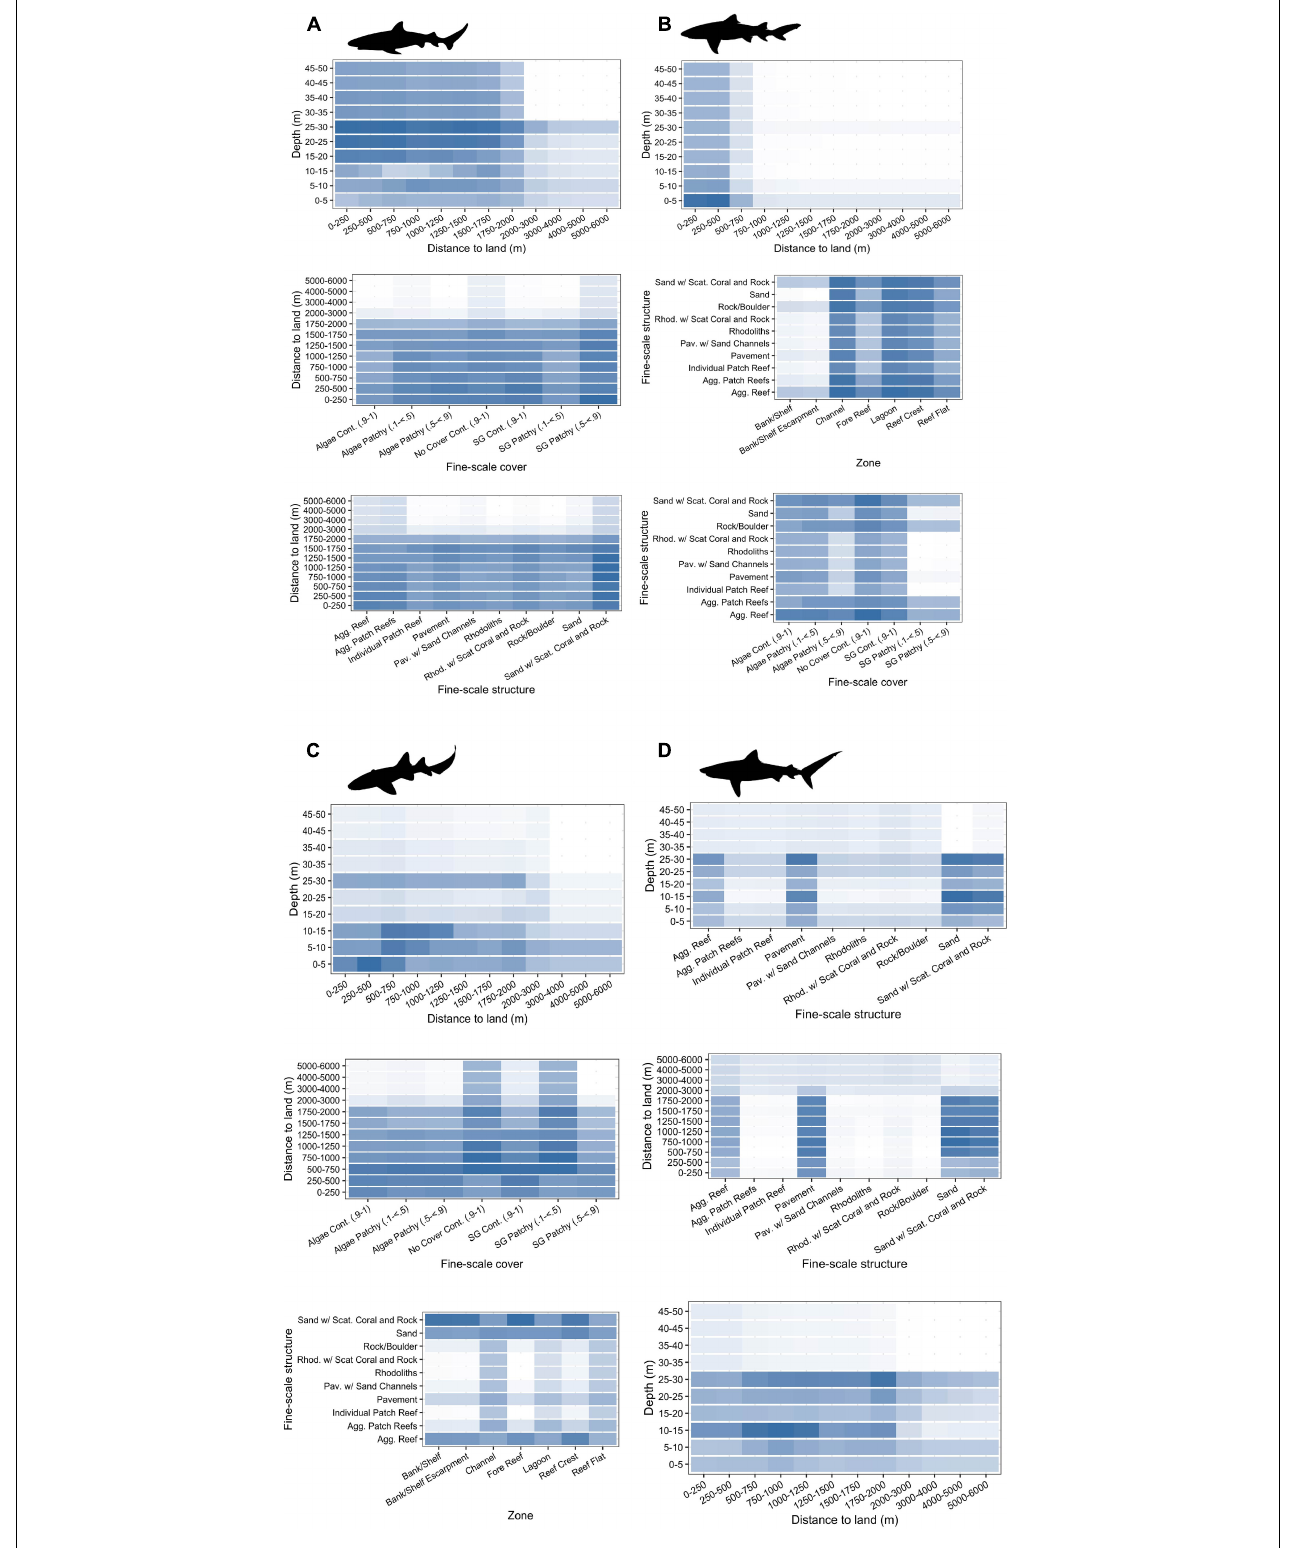
FIGURE 4 | Top three two-way interactions (ordered from top to bottom) displayed and extracted from random forest models for (A) Caribbean reef sharks, (B) lemon sharks, (C) nurse sharks, and (D) tiger sharks. Mean marginal effects (ˆy) are shown in each two-way interaction partial dependency plot with colors indicating a continuum from high (blue) to low (white) probabilities of relative selection. Partial dependency plots involving depth were restricted to 50 m depth for each species.